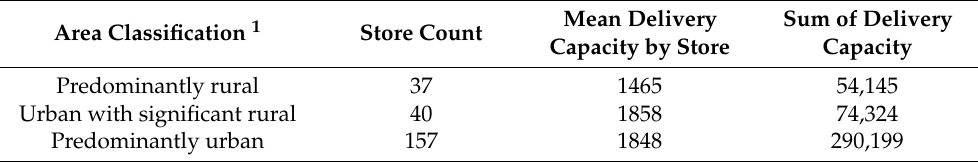
Table 3. Delivery capacity by urban–rural classification of stores.